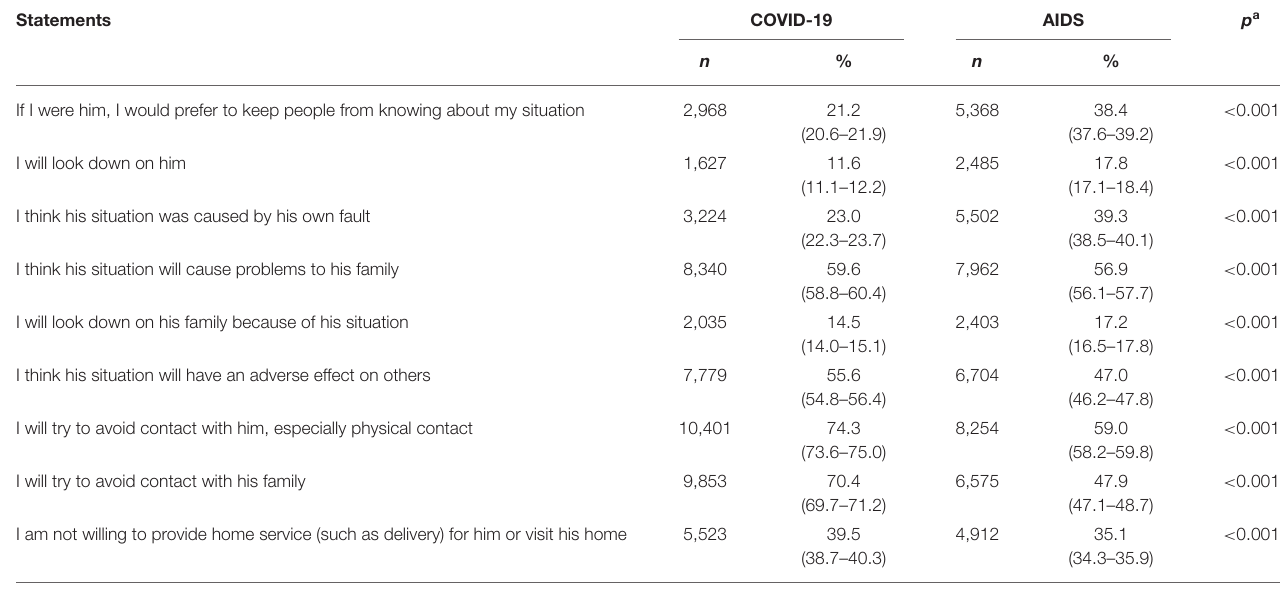
TABLE 2 | Percentage and 95% CI of participants who “agree” or “strongly agree” with statements about their own attitudes toward the person described in the vignette ( N =